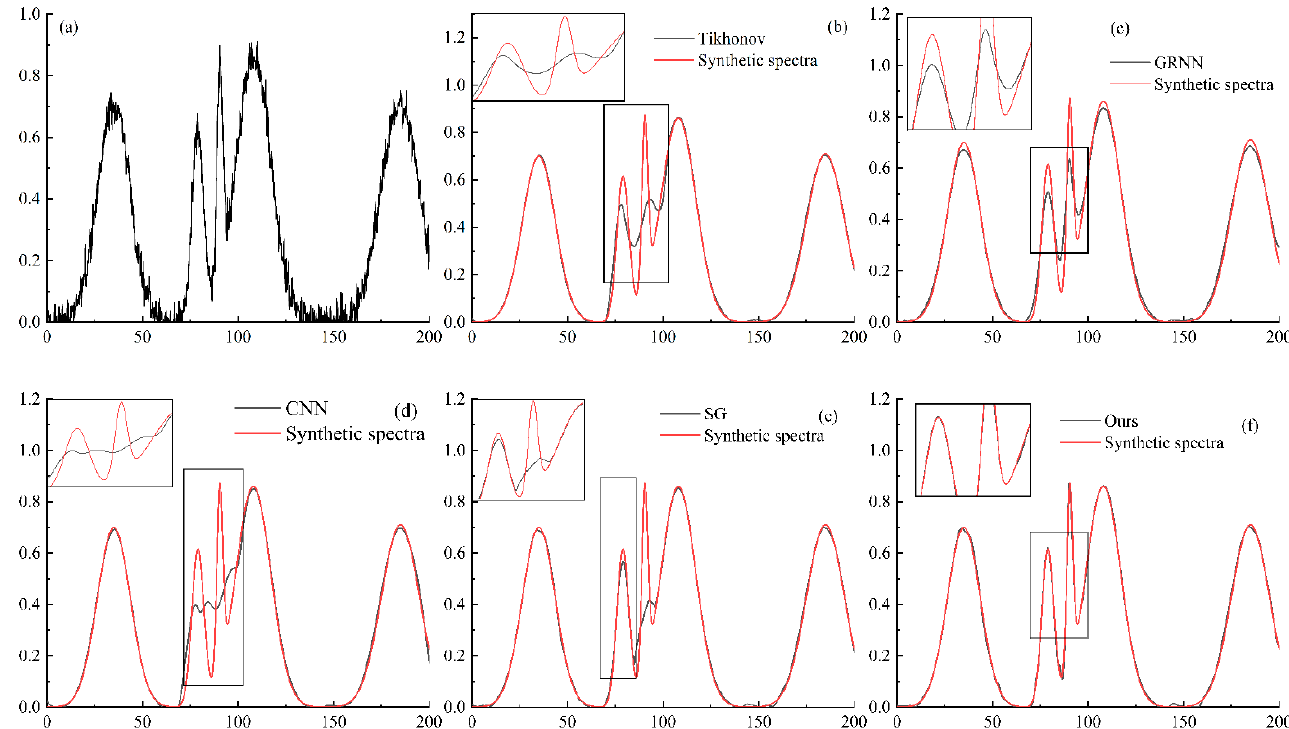
Figure 5. The quantitative analysis results of the synthesized spectrum. ( a ) The score of RMSE, ( b ) The score of R 2 . ( c ) The score of SNR